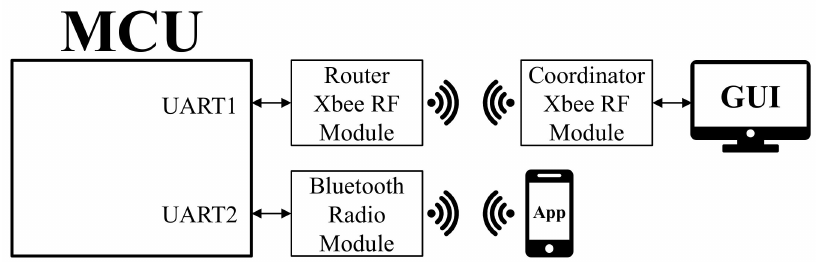
Figure 8. Block diagram of the wireless communication